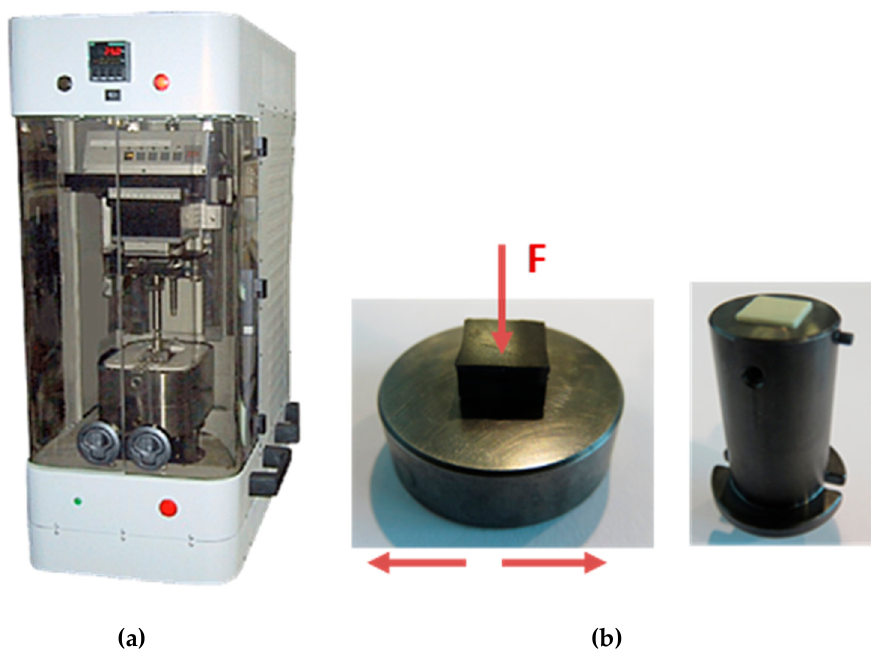
Figure 1. ( a ) CETR-UMT tribometer and ( b ) pin-on-disc testing configuration.